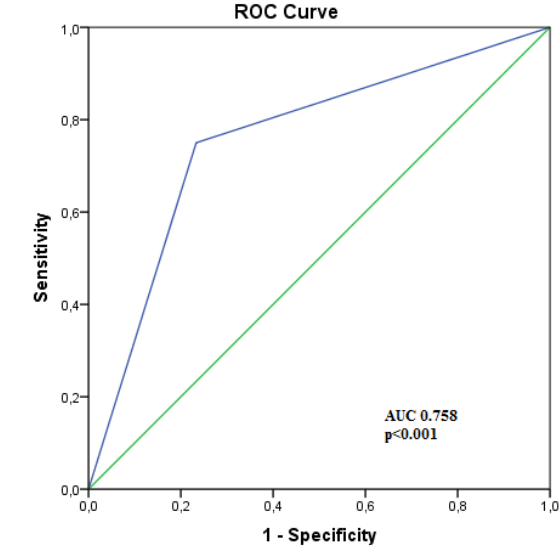
Table 1: Demographic and clinical data of the patient population.